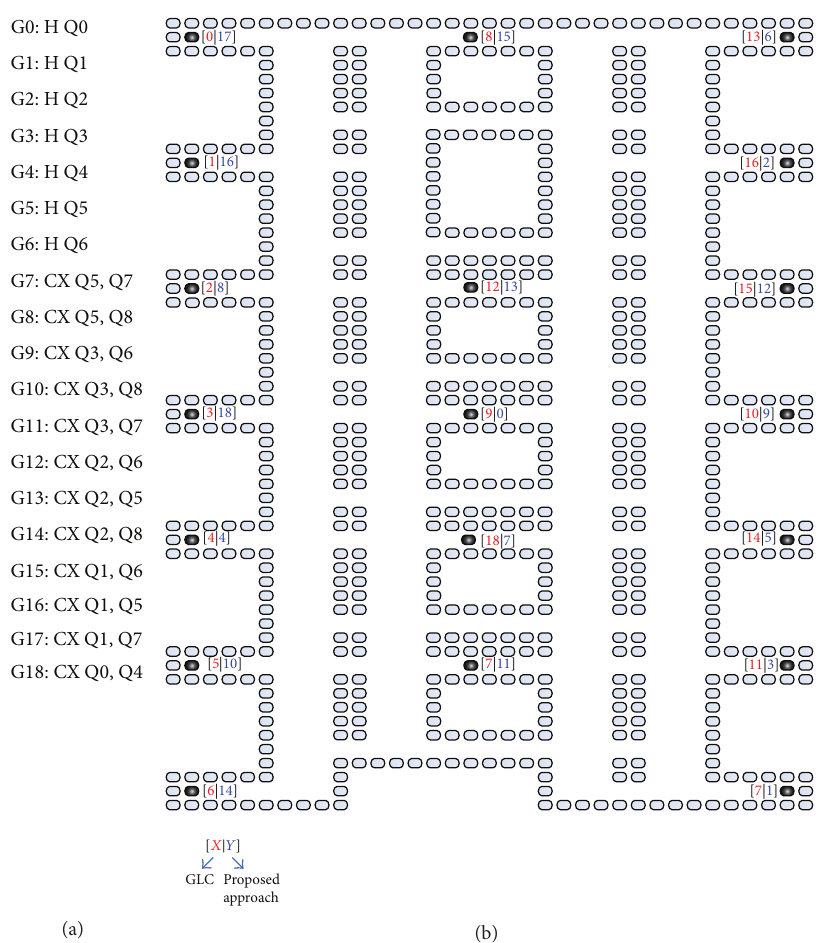
Figure 5: (a) A circuit netlist. (b) The gate locations assigned by GLC technique and the proposed approach.